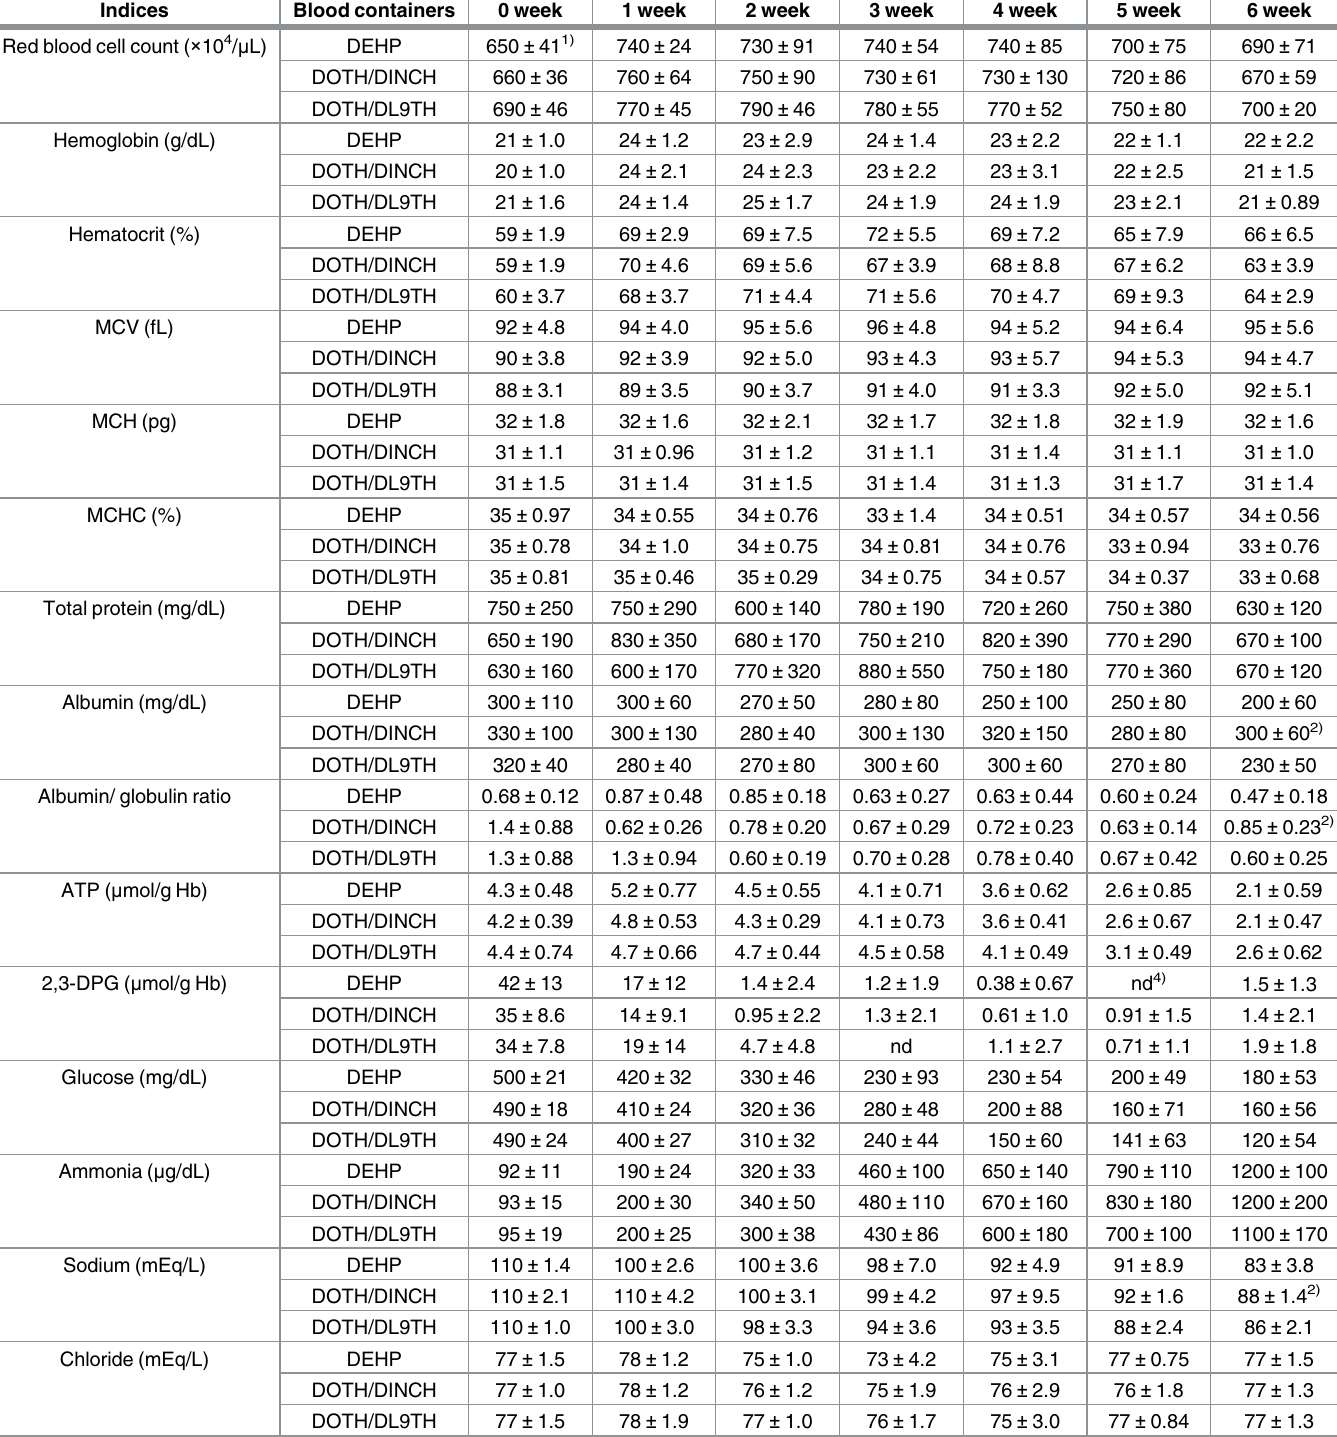
Table 2. Hematological and blood chemical analysesof